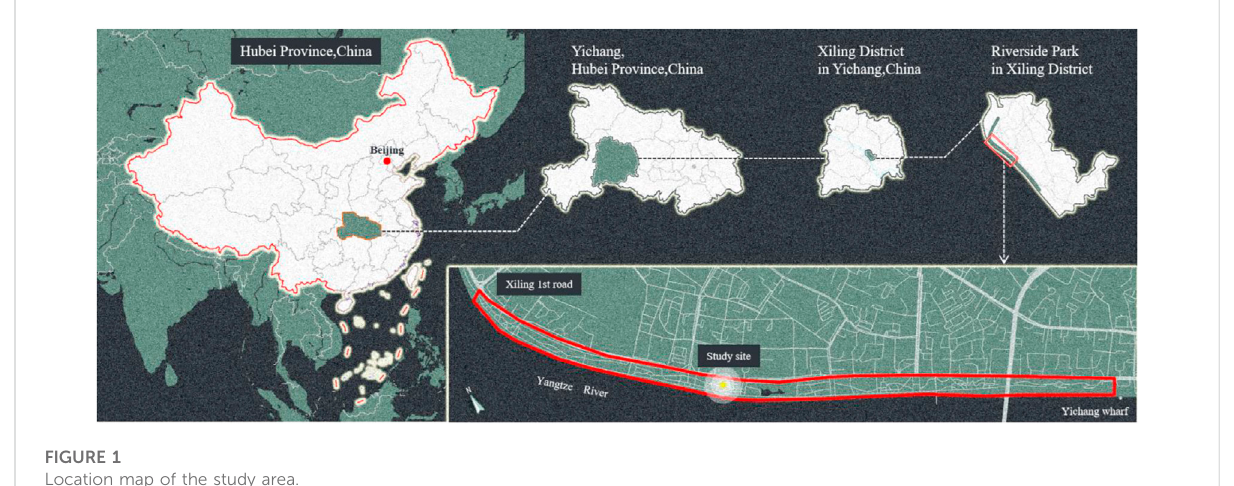
FIGURE 1 Location map of the study